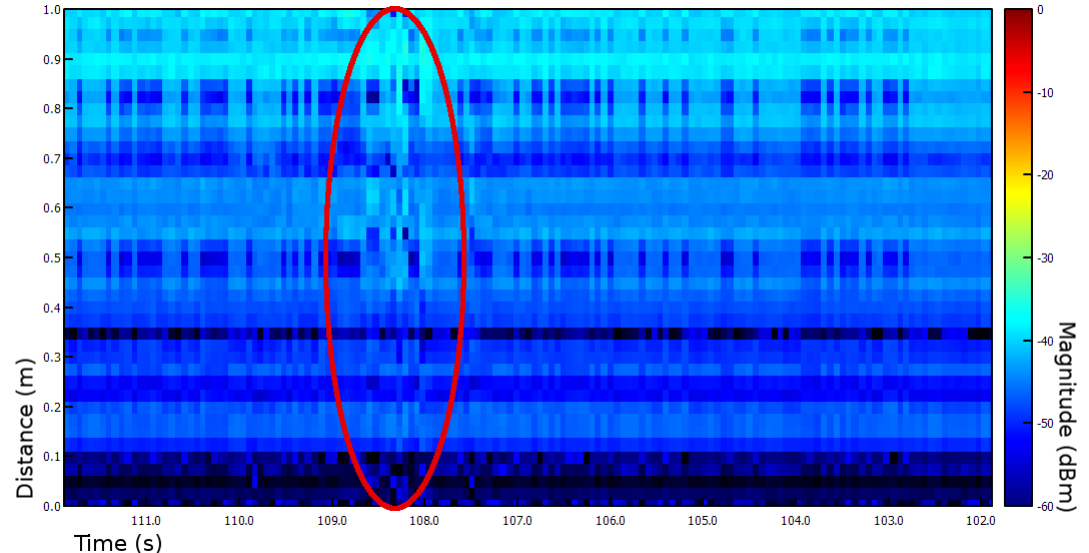
Figure A5. History plot showing an insect (highlighted by a red ellipse) in H3 (108–109